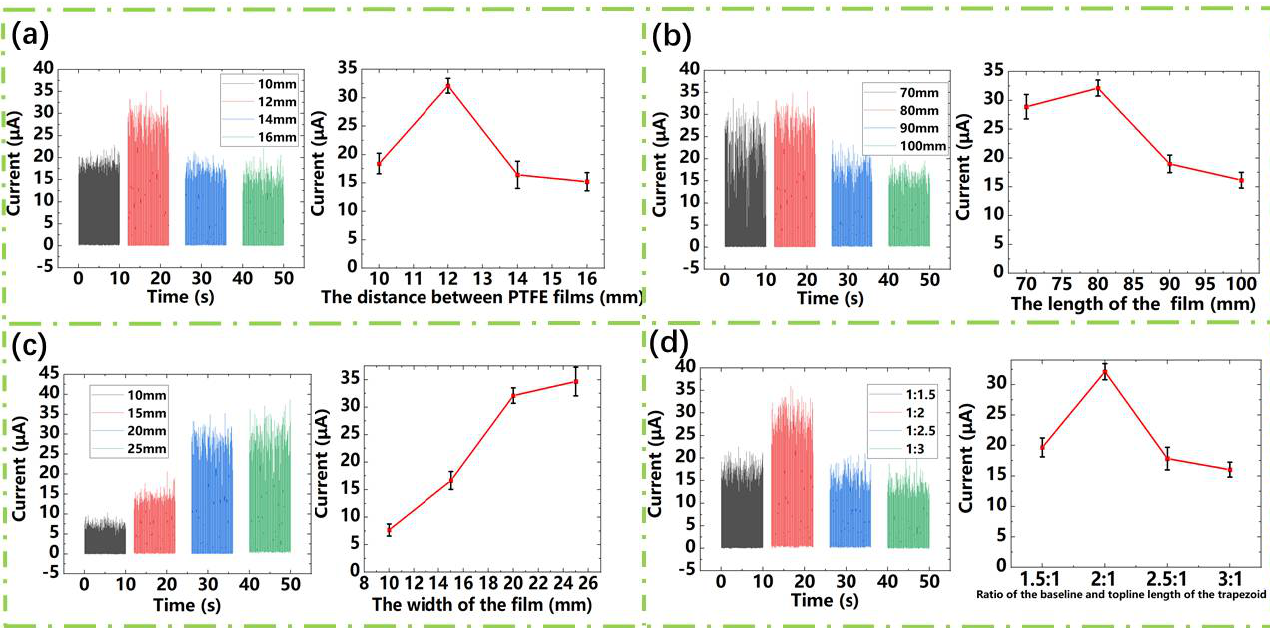
Figure 4. The influence of geometric size on the rectified short-circuit current. ( a ) Current vs. distance between the PTFE friction layers. ( b ) Current vs. the Al/Kapton/Al film length. ( c ) Current vs. the Al/Kapton/Al width of the film. ( d ) Current vs. the ratio of the topline and baseline length of the Al/Kapton/Al